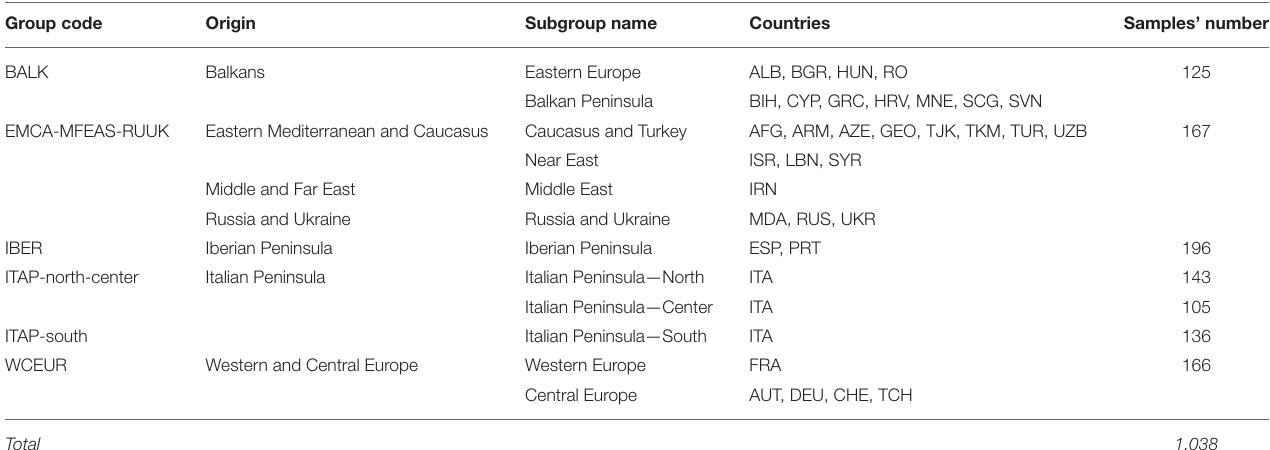
TABLE 1 | Grapevine varieties collected across Europe, Caucasus, Middle, and Far East, genotyped by 18k SNP genotyping array and arranged based on their passport data (for a detailed list, see Supplementary Table 1 ). Group